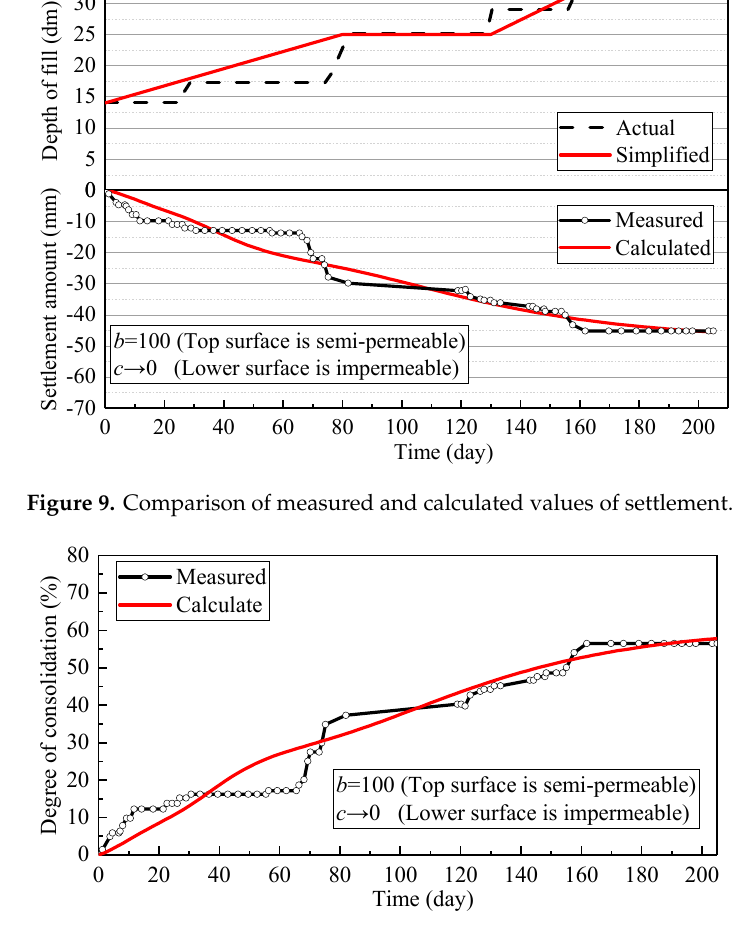
Figure 10. Comparison of the calculated and measured consolidation degrees.